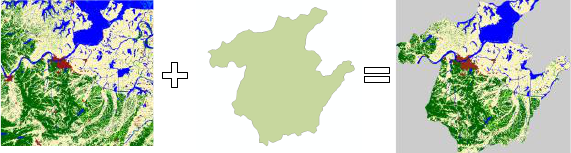
Figure 4 . Visualization of land cover data masking. Areas at Globeland 30 land cover maps outside user requested area will be discarded.